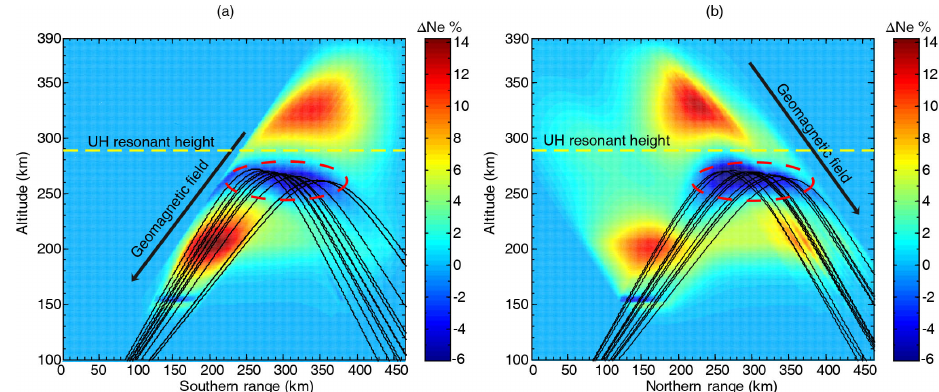
Figure 2. An example of the ray path of HF heating waves. The heating waves are transmitted along the geomagnetic field lines (a) and perpendicular to the geomagnetic field (b) . The background is the ionospheric electron density change at a heating duration time of 180s in response to the oblique heating waves. The heating ERP is 300MW and the heating frequency is 6MHz.